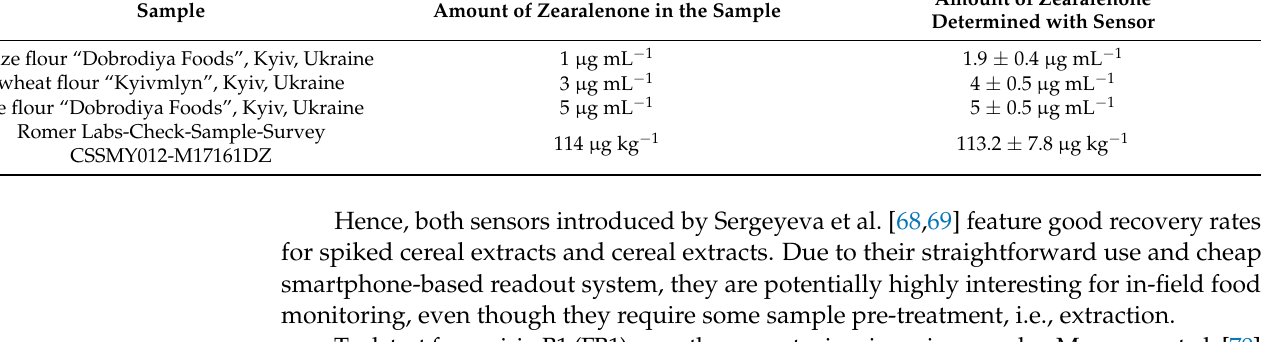
Table 4. Zearalenone detection in cereal samples using MIP membrane-based fluorescence sensor; n = 5 in all experiments; [69].